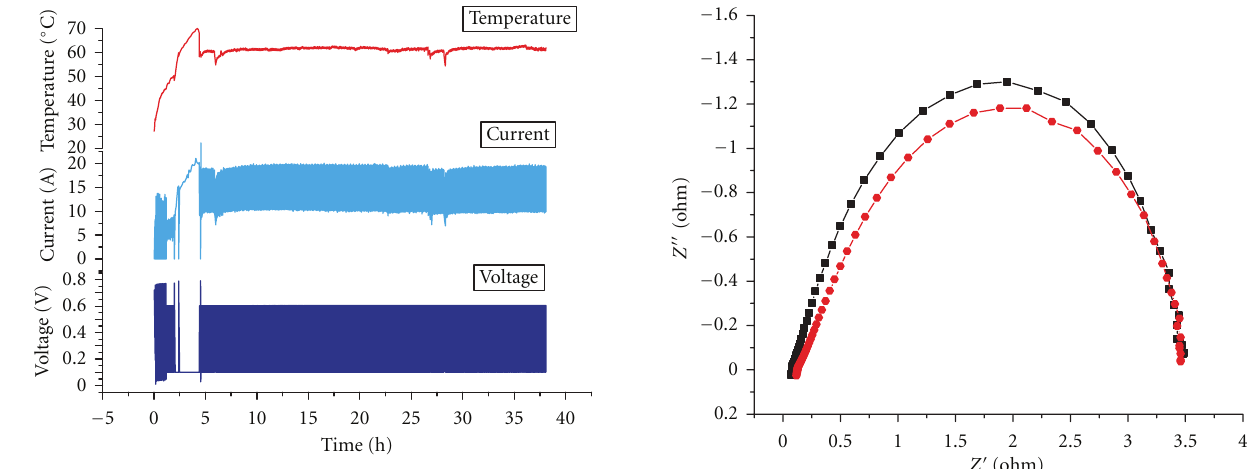
Figure 6: Durability of the composite membrane performance to repeated cycling.